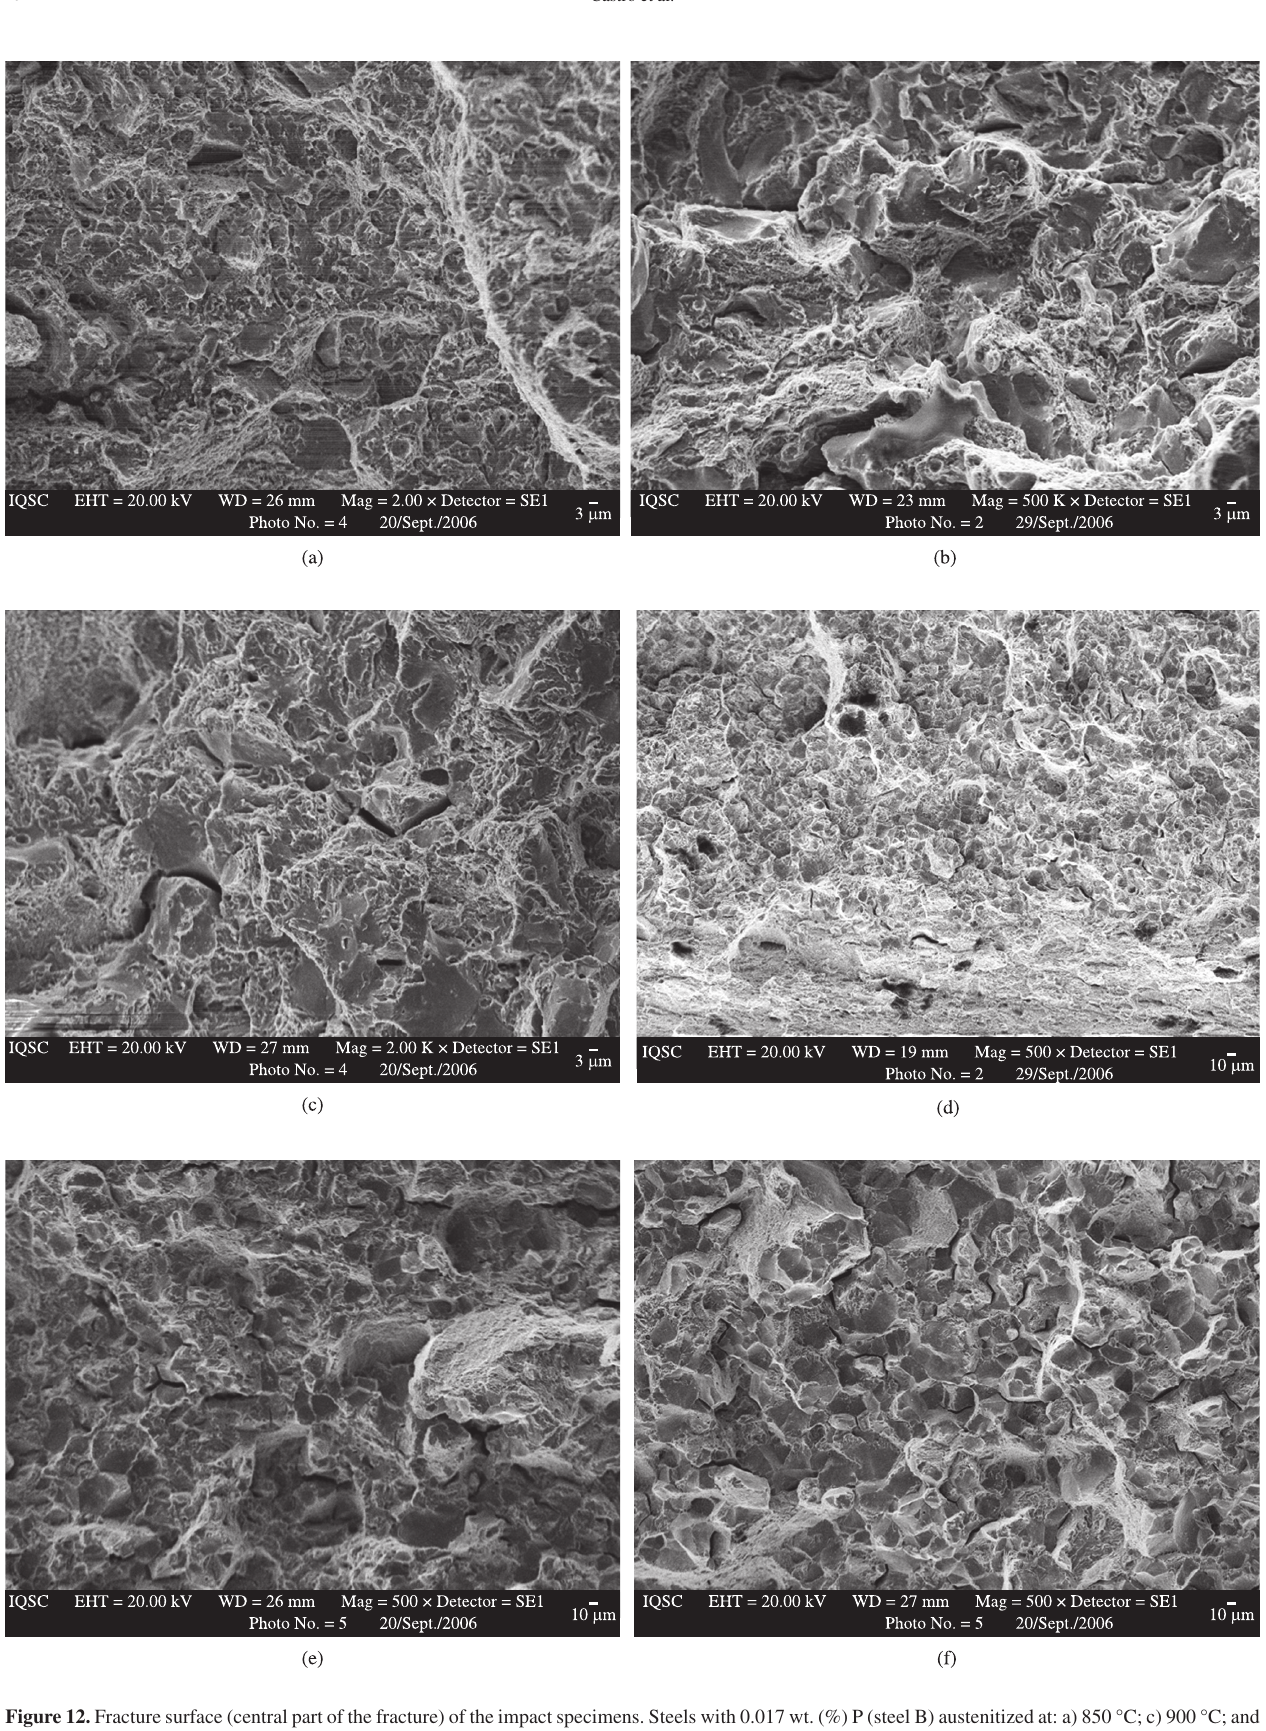
Figure 12. Fracture surface (central part of the fracture) of the impact specimens. Steels with 0.017 wt. (%) P (steel B) austenitized at: a) 850 °C; c) 900 °C; and e) 1000 °C. Steels with 0.031 wt. (%) P (steel D) austenitized at: b) 850 °C; d) 900 °C; and f) 1000 °C. The specimens were tempered at 500 °C for 64